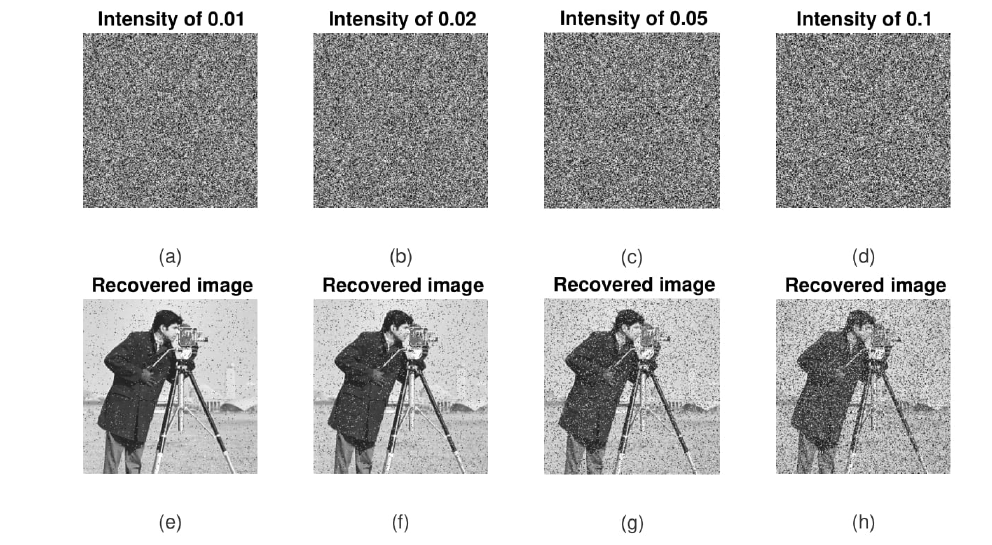
Figure 19. Robustness against salt and pepper noise.